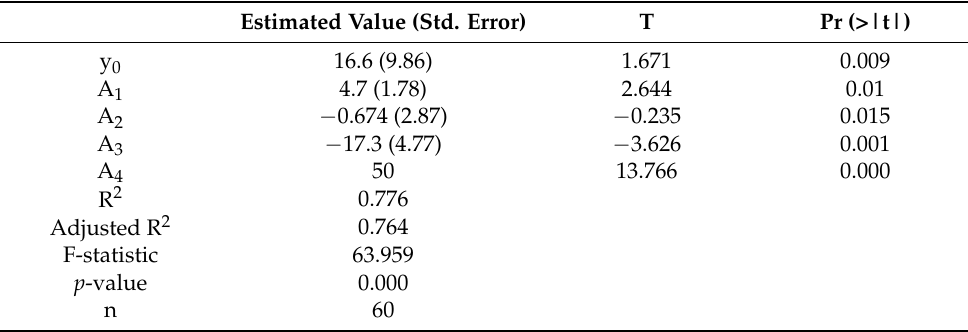
Table 7. Parameters of the regression equation. Estimated Value (Std.